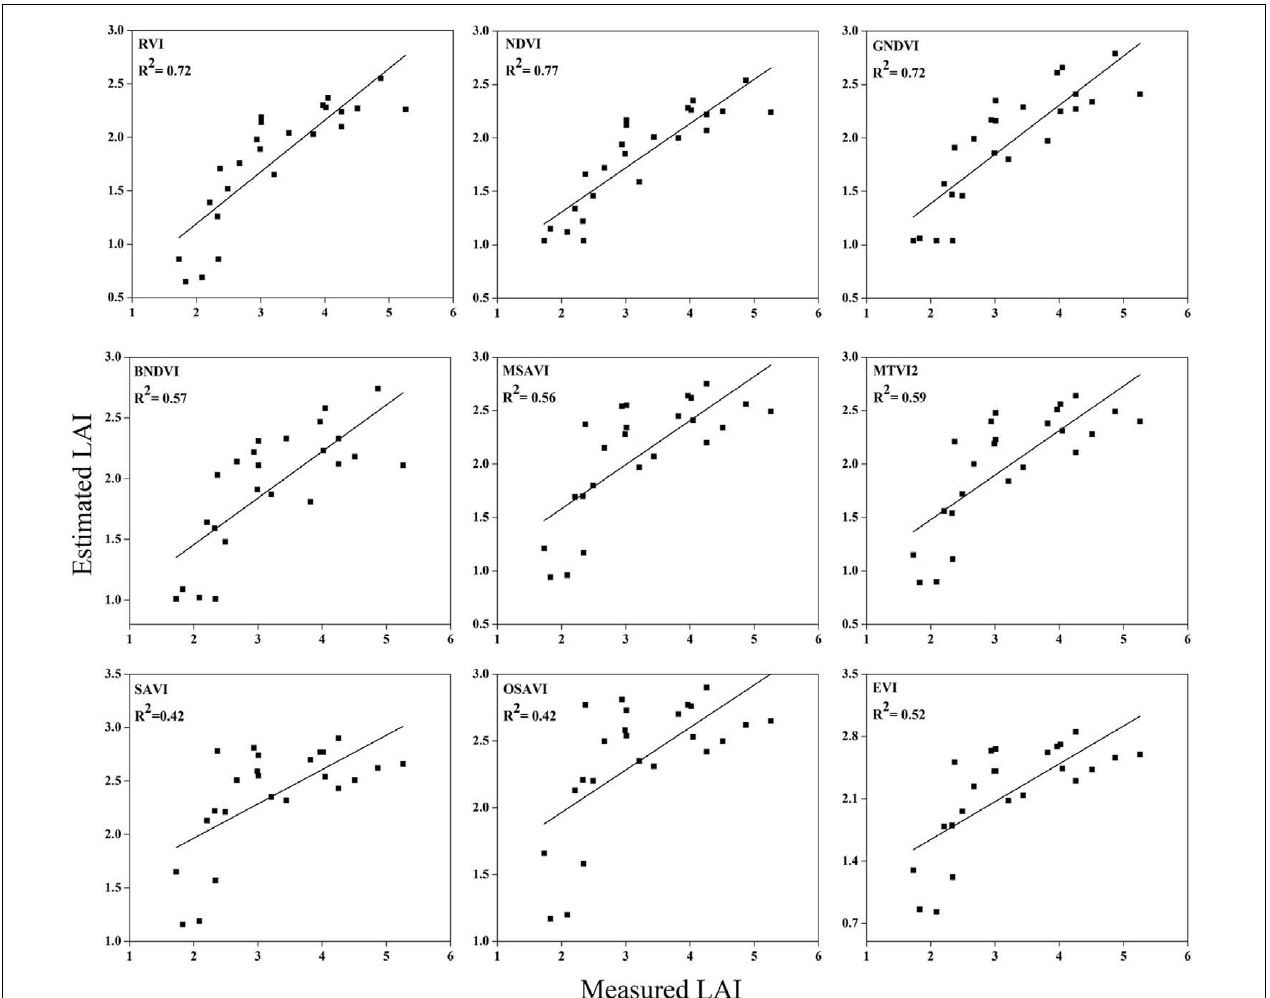
FIGURE 10 | Relationship between measured LAI and estimated LAI at